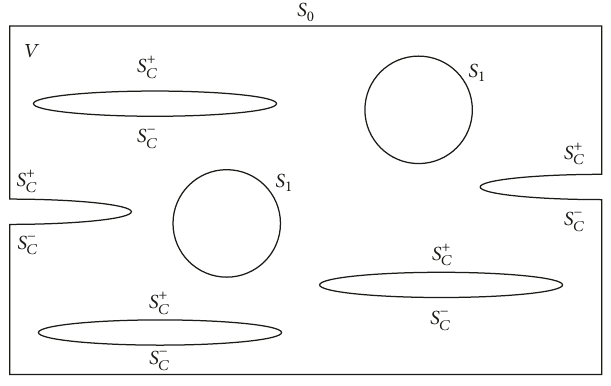
Figure 1: An elastic solid containing edge and embedded